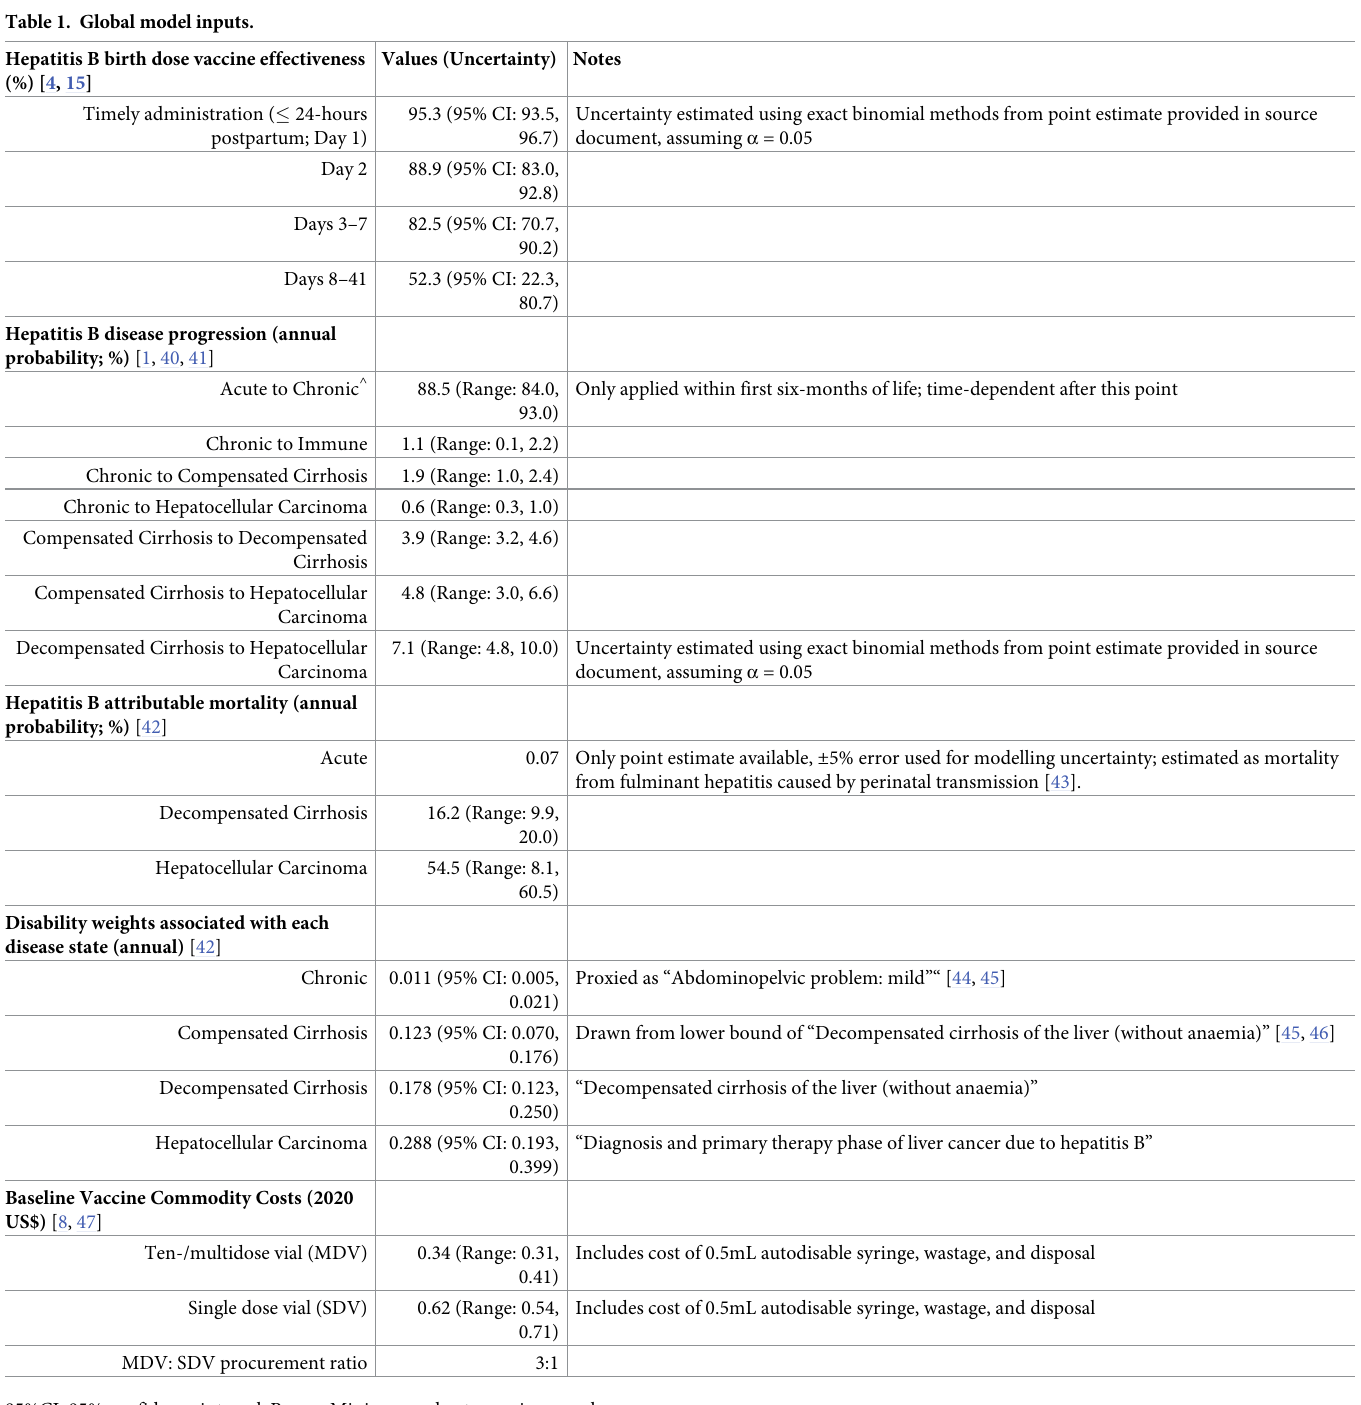
Values (Uncertainty)